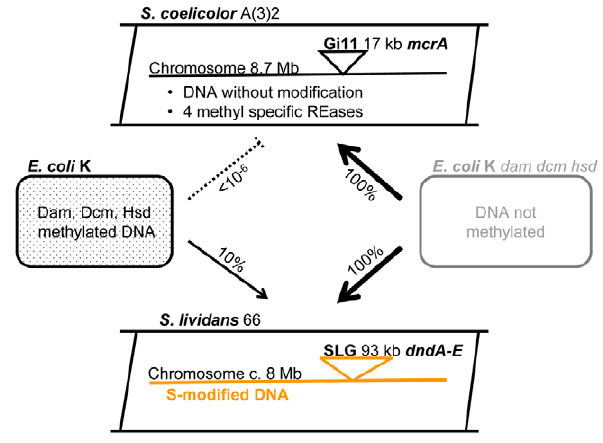
Figure 1. Streptomyces and E.coli strains used as sources of recombinant DNA. Gi11 (=SLP1) and SLG are genomic islands (DNA inserts) which are unique to S. coelicolor A(3)2 and S. lividans 66 , respectively. The numbers on the arrows between the E. coli